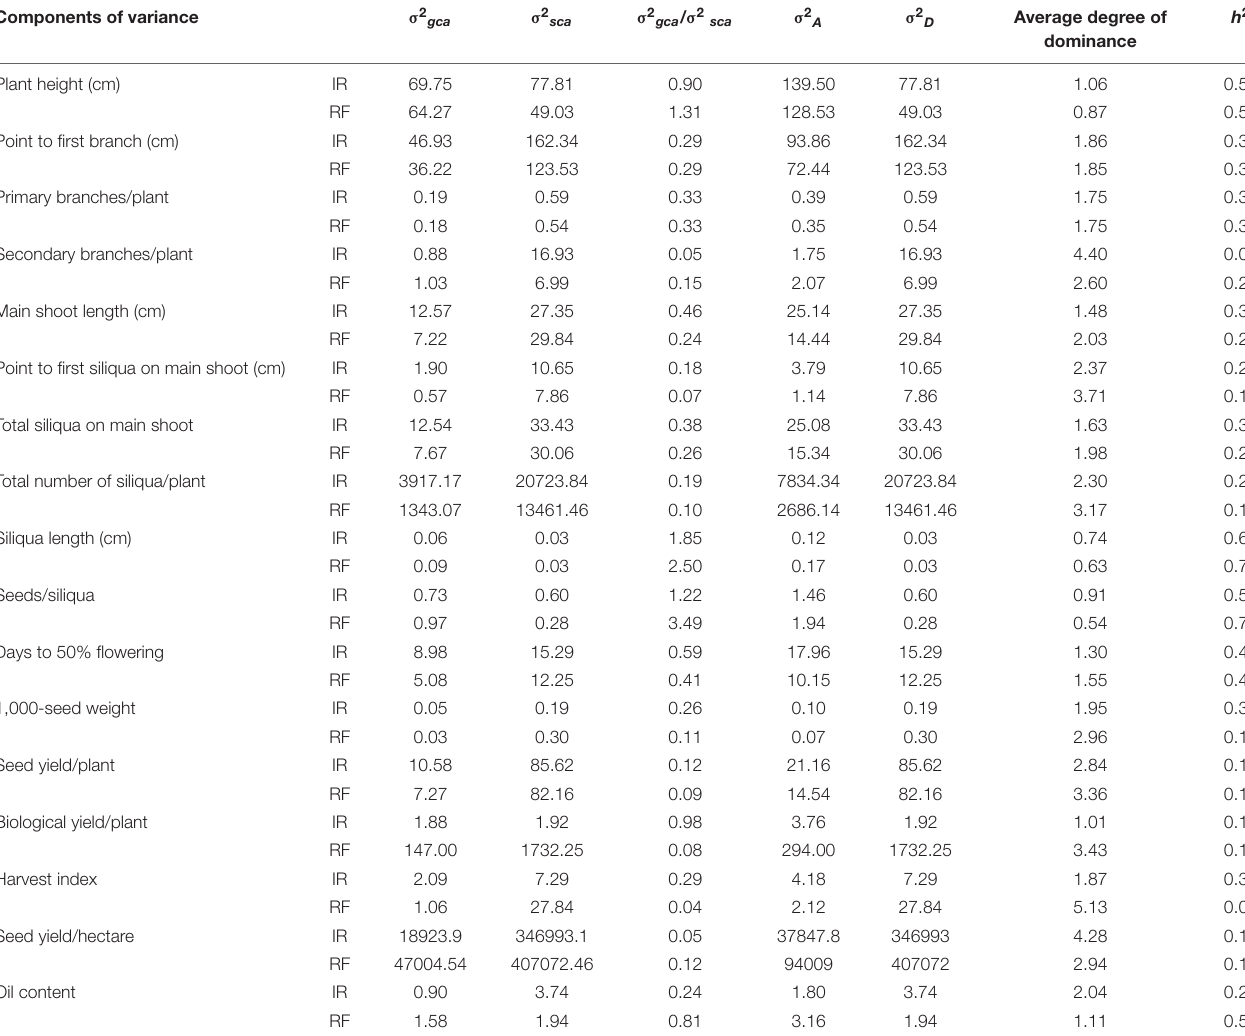
TABLE 3 | Estimates of genetic components of variance for seventeen characters in B. carinata -derived B. juncea lines (CDLs) and their hybrids evaluated under irrigated and rainfed conditions. Components of